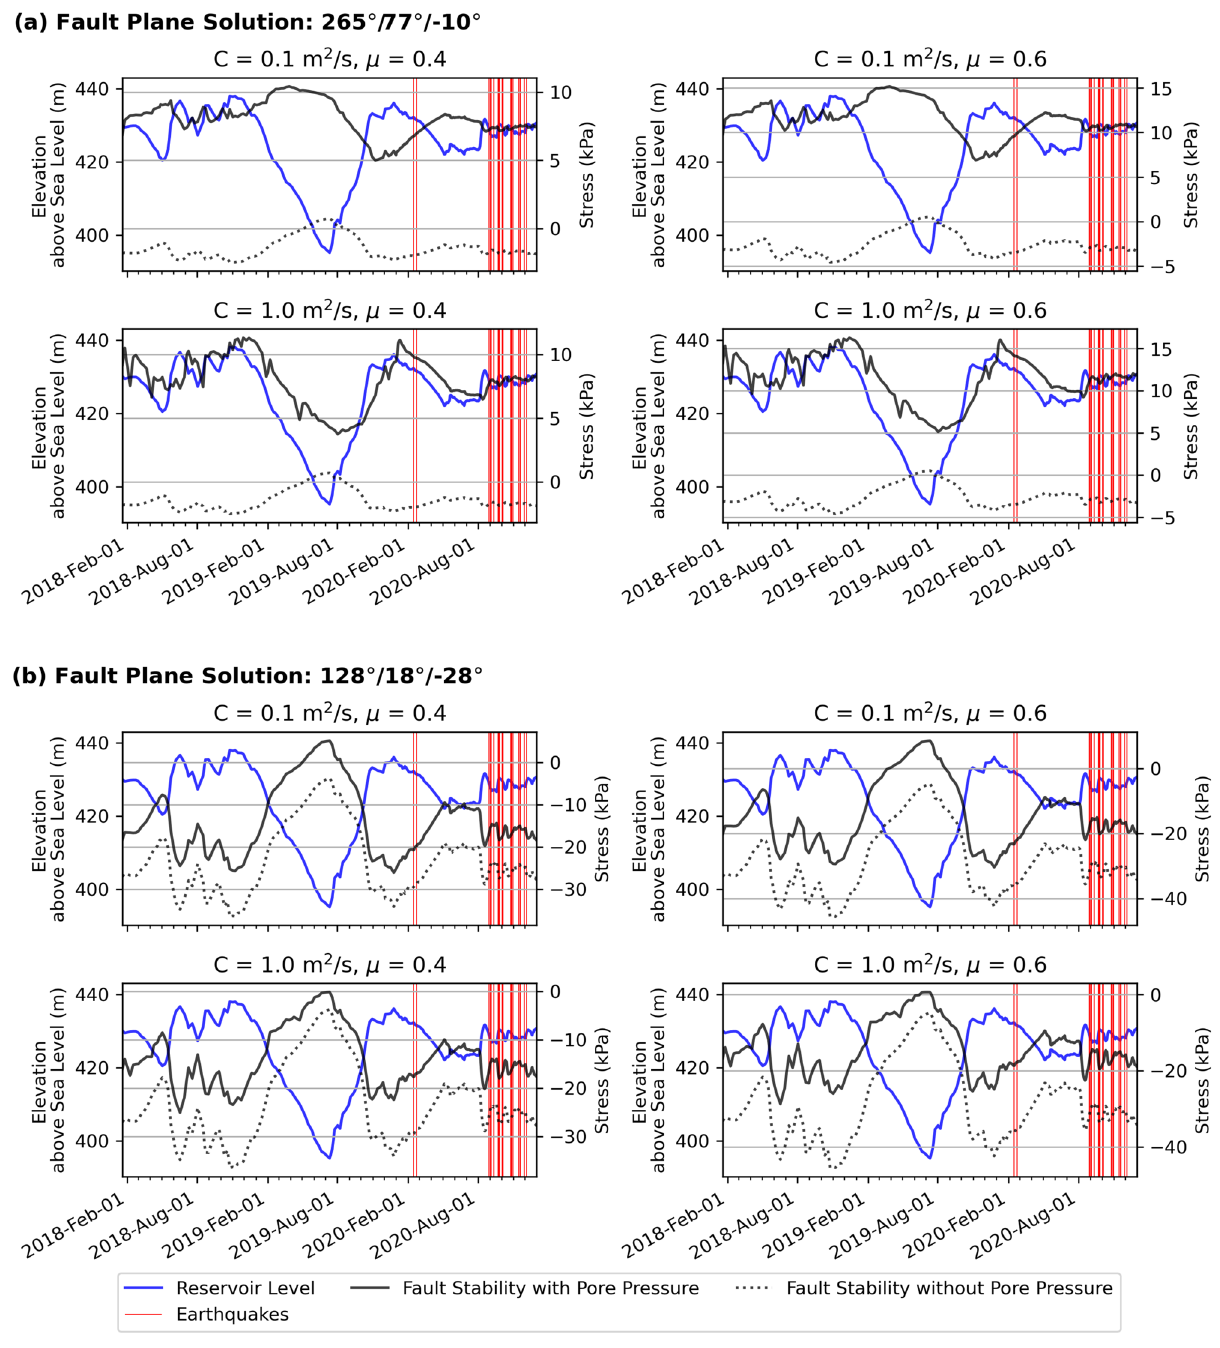
Figure 3. Temporal variation of change of fault stability. ( a , b ) The change of fault stability predictions for fault plane solutions of the largest earthquake on 29 August 2020 in dry (without pore pressure; dotted line) and wet (with pore pressure; black solid line) conditions. Failure is encouraged if the fault stability is positive. The solutions are for longitude = 80.73842° and latitude = 7.26497° (epicenter of the 29 August 2020 M W 2.9 event) and 2 km depth. Figure made with Python Matplotlib 62